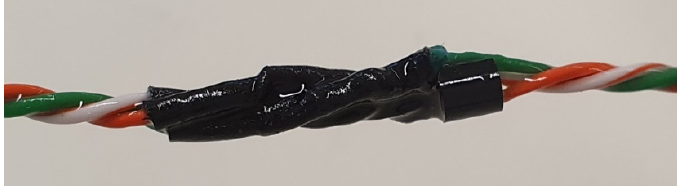
Figure 11. Sensor located on the 1-wire cable.